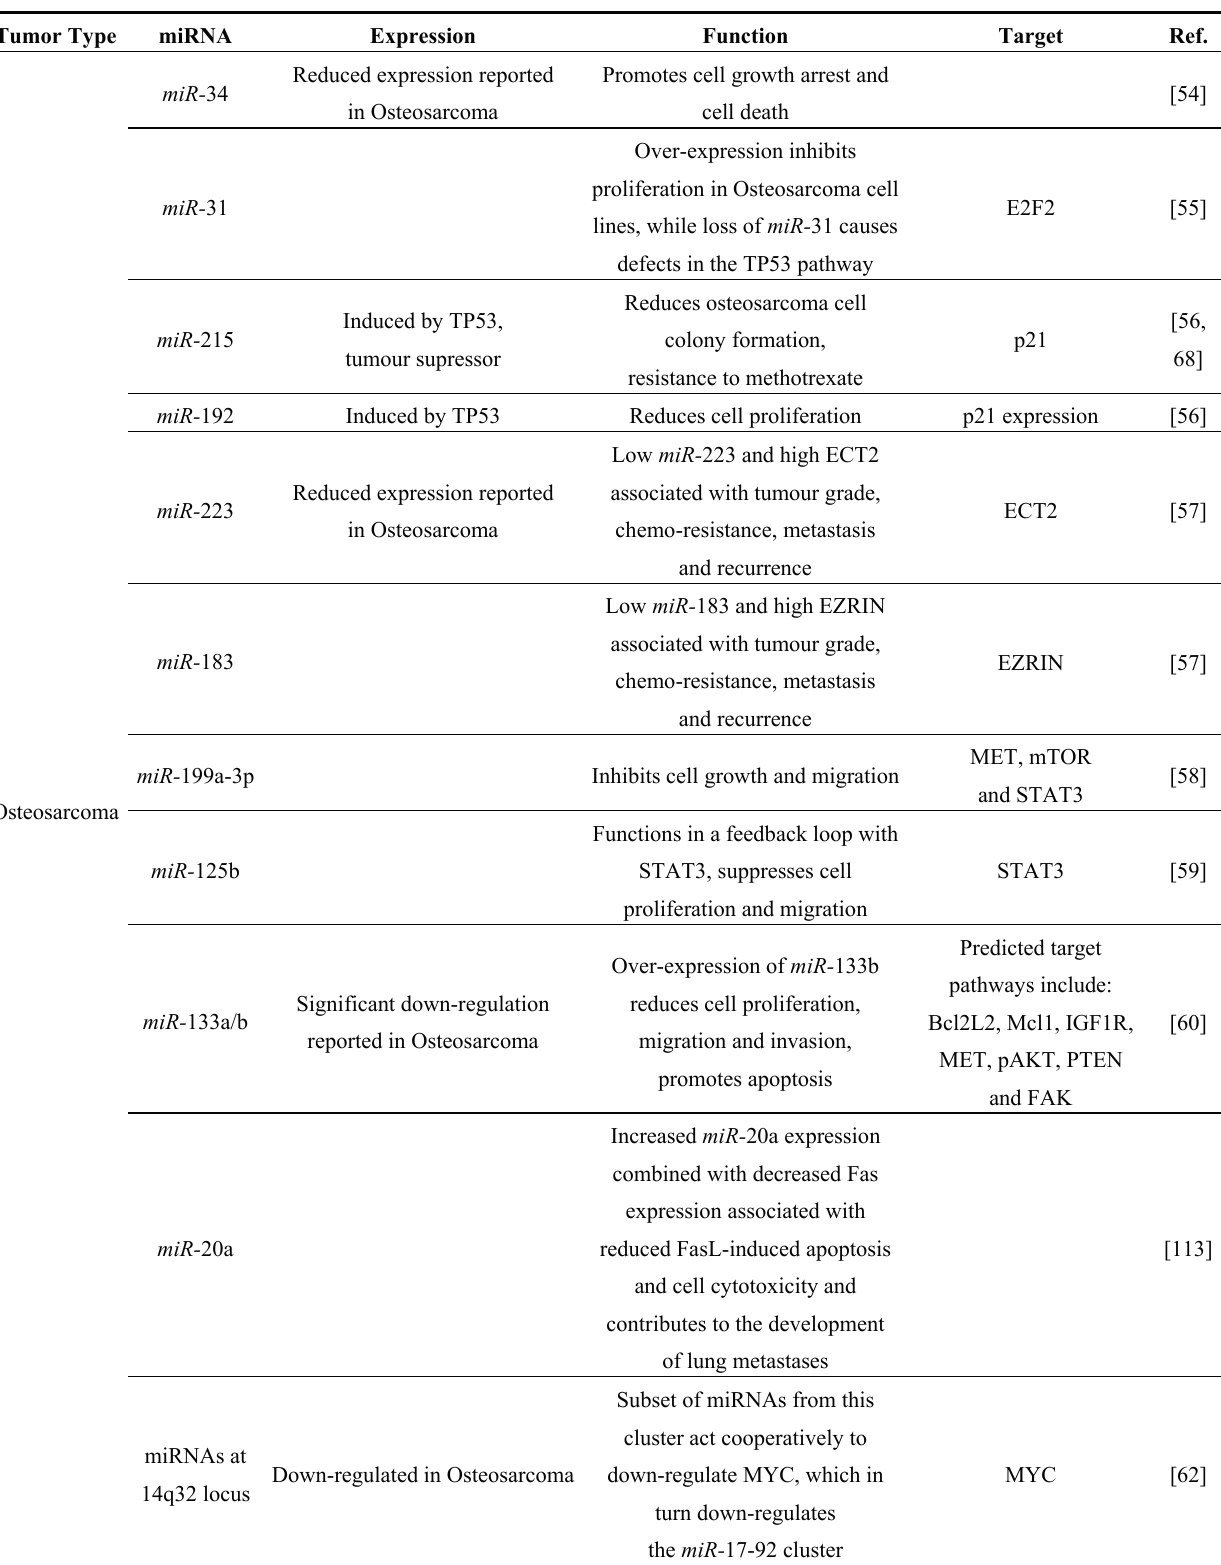
Table 1. MiRNAs Dysregulated in Pediatric Sarcomas.The table lists miRNAs described in the literature as showing dysregulated expression in the various pediatric sarcomas together with expression change observed, cellular effect and target gene(s) where known, as well as reference where the findings are